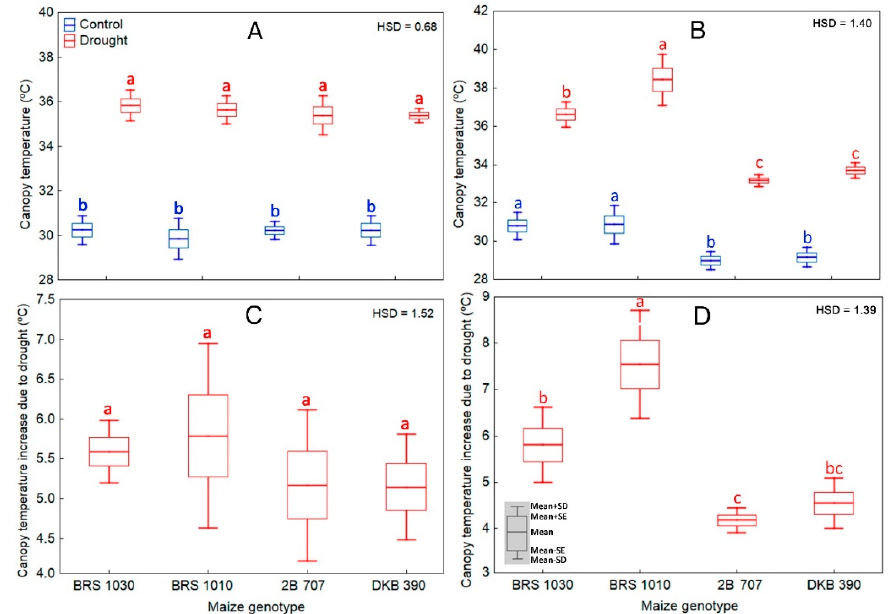
Figure 3. Canopy temperature for plants of maize genotypes grown in soil at field capacity (control) or subjected to water shortage (drought) at pre-flowering stage on the 4th ( A ) and 12th ( B ) day of stress. Drought-induced canopy temperature increase in maize genotypes at 4th ( C ) and 12th ( D ) day of stress. ( A ) showed significant differences between treatments regardless of genotype ( p < 0.01), which indicates that the means of the genotypes should be compared between the treatments. Boxes from the same genotype under different treatments, topped by the same letter, are not statistically different according to Tukey’s test ( p < 0.05). In ( B ), there was significant interaction between treatment and genotype ( p < 0.01), which indicates that the means of the genotypes should be compared by treatment. Boxes from different genotypes under the same treatment, topped by the same letter, are not statistically different according to Tukey’s test ( p < 0.05). In C and D , boxes from different genotypes, topped by the same letter, are not statistically different according to Tukey’s test ( p < 0.05).